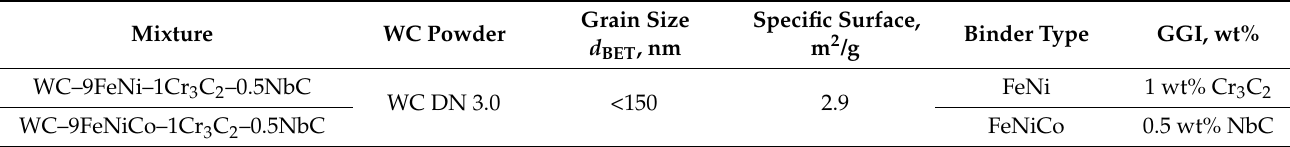
Table 1. Starting mixtures